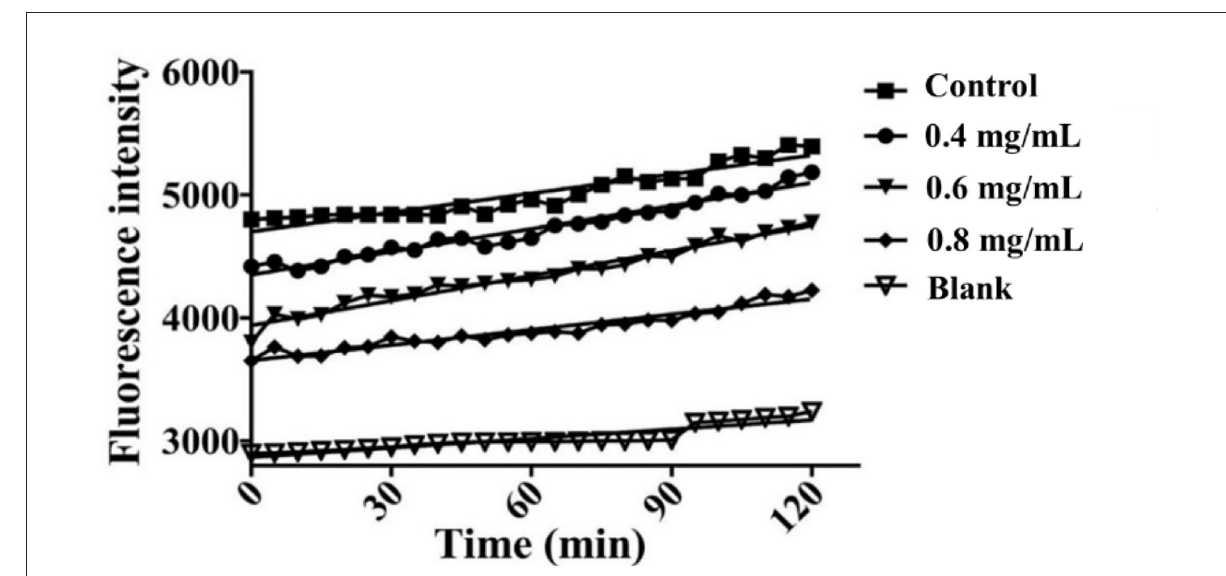
FIGURE5 The time-scan of the relative fluorescence intensity for ROS levels of the 1.4mM H 2 O 2 -induced HSF cells after treatment with 0.4, 0.6, and 0.8 mg/ml P-3 for 24h, respectively. The HSF cells only treated with DMEM for 24h were used as blank. Control was treated with 1.4mM H 2 O 2 for